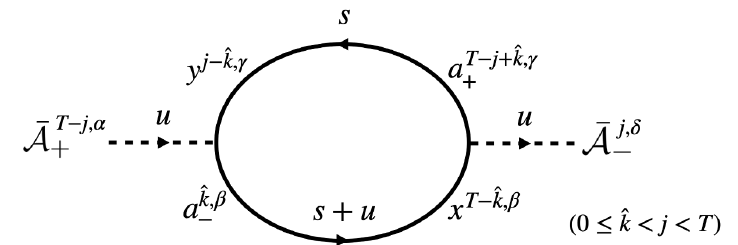
Figure 4 . The only class of divergent diagrams contributing to the 1-loop effective action (3.12) for theories with Lax connection of the form (3.1). These diagrams are summed over the indices j, ˆ k in the range